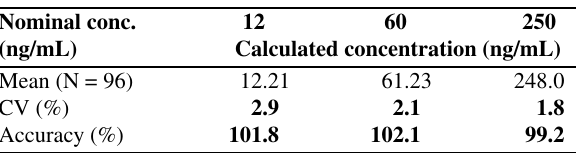
Table 7: Precision and accuracy of candesartan determination wit- hin the study. Nominal conc.